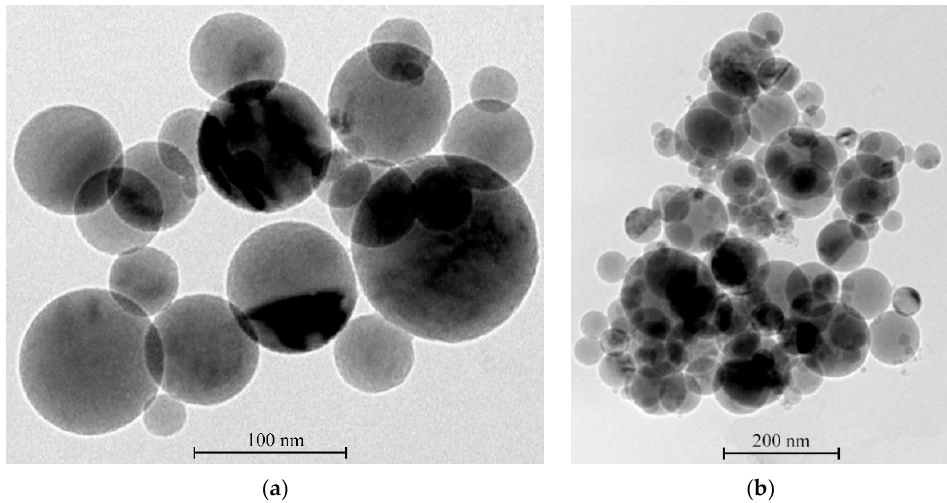
Figure 8. TEM image of aluminum nanoparticle size with magnification ( a ) × 60 × 10 4 times and ( b ) × 30 × 10 4 times.